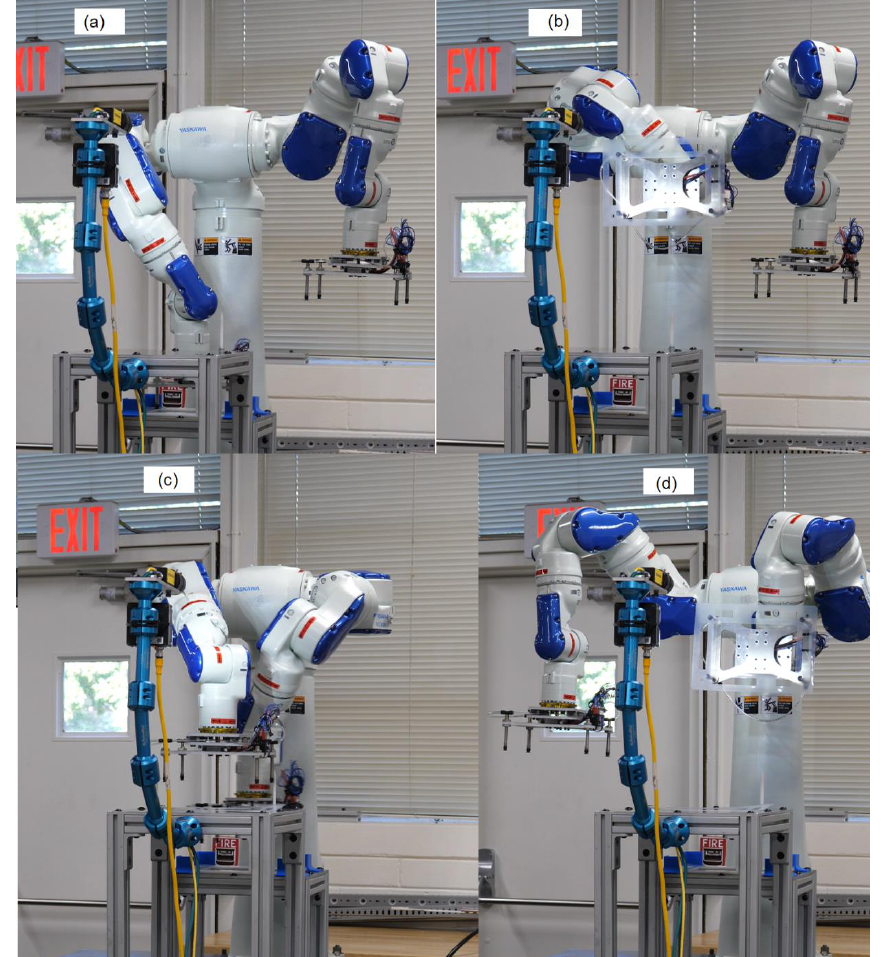
Figure 5. Fuel cell component transferring steps from bin to presenter. ( a ) Arm A picks a component (in this case, a gasket) from bin; ( b ) arm A brings the gasket in front of camera while arm B waits for image analysis results; ( c ) arm A inserts the gasket in the presenter while arm B picks a new gasket from the bin; ( d ) arm B brings the gasket in front of camera while arm A waits for image analysis results. The cycle for arm B was identical to the cycle of arm A, and out of phase one